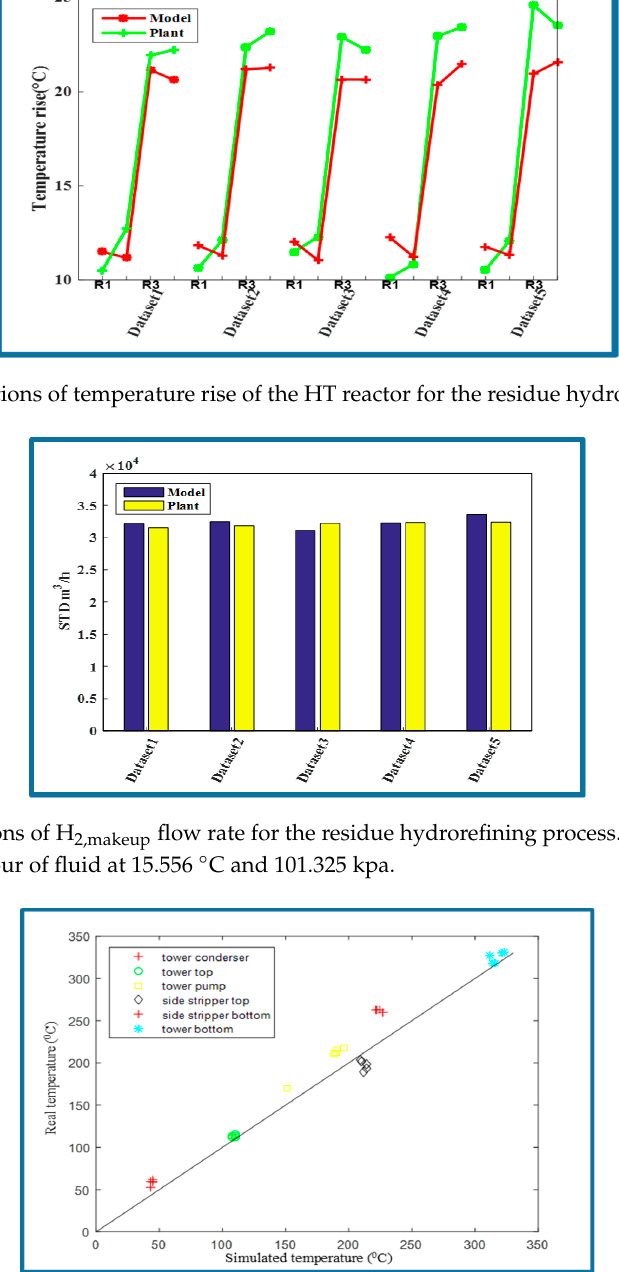
Figure 13. Predictions of temperature rise of the HT reactor for the residue hydrorefining process.